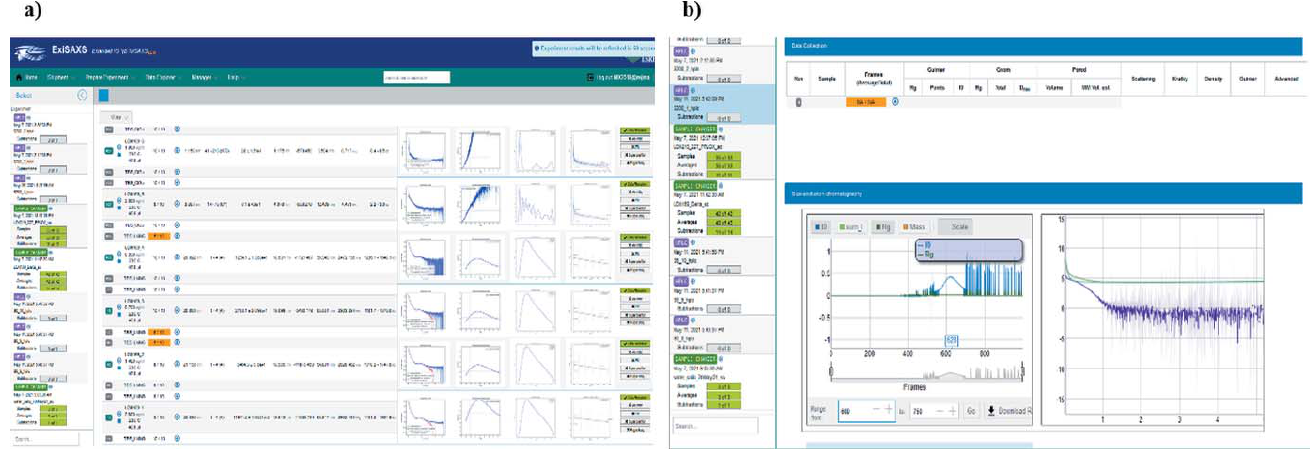
Figure 8 Results of ( a ) sample changer and ( b ) SEC-SAXS experiments displayed in